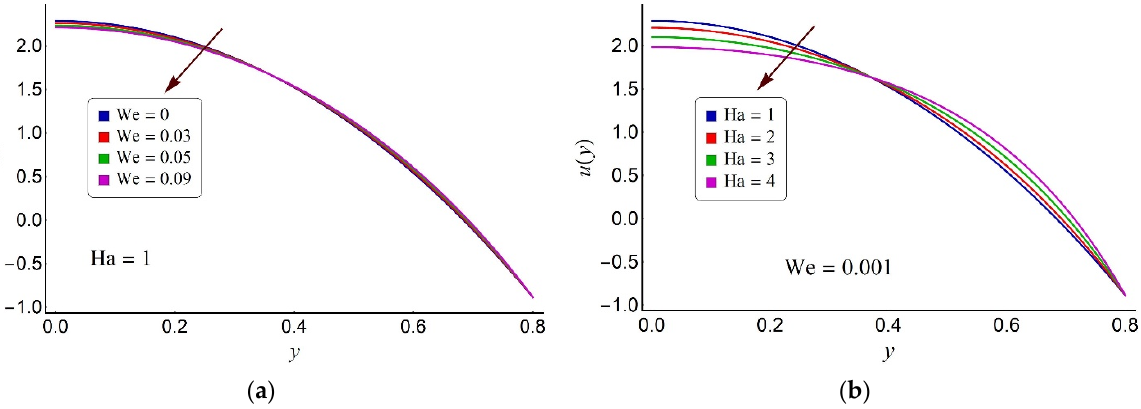
Figure 2. Alterations in the axial velocity distribution for distinct values of ( a )Weissenberg